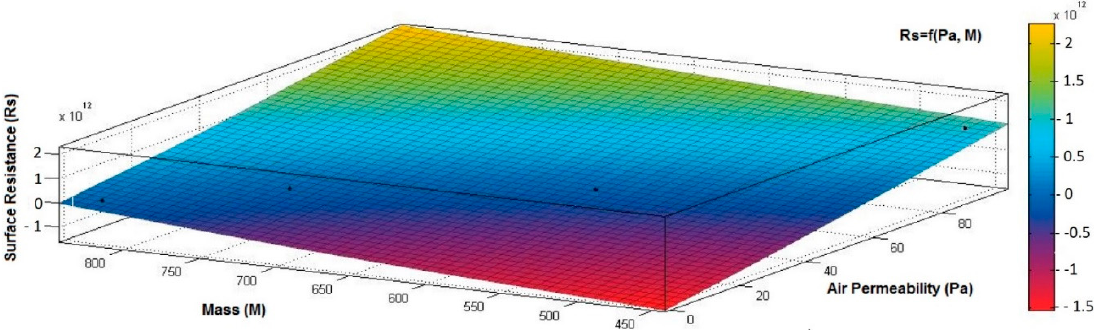
Figure 18. 3D representation Rs = f( δ , Pa ) samples coated with a conductive polymeric paste-based PVDF.